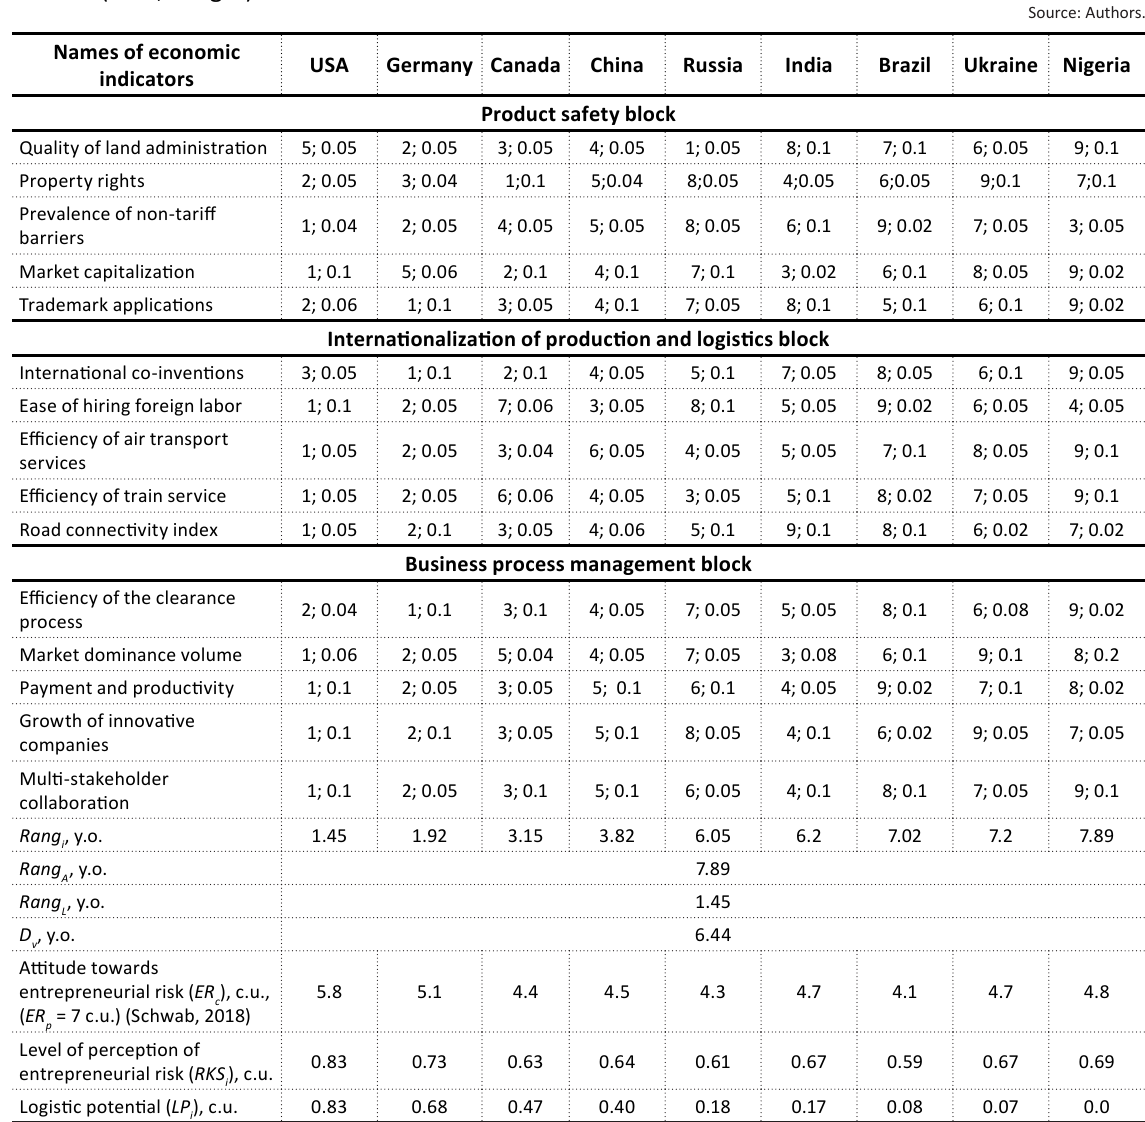
Table 2. Assessment of logistic potential of the main countries of agricultural production of the world in 2018 (rank,